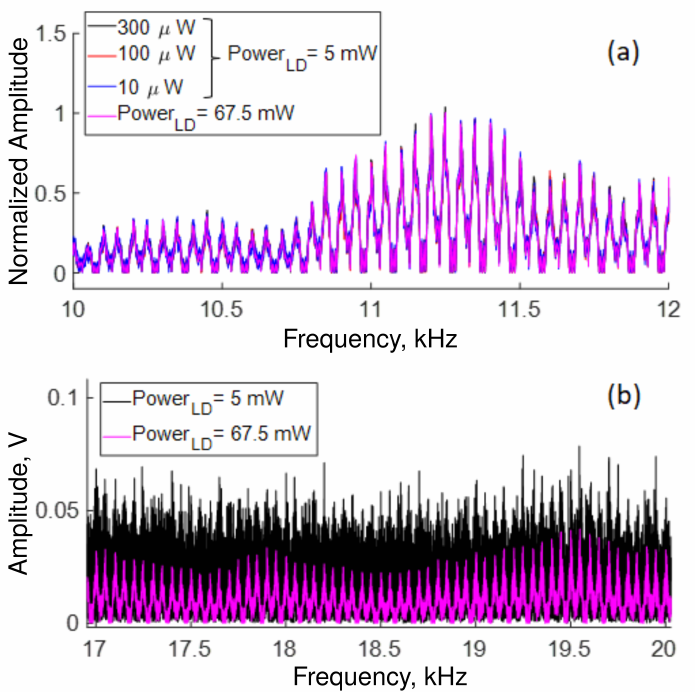
Figure 11. Influence on transmission response of ( a ) polarizer transmission and LD output power in the 12 kHz region, and of ( b ) LD output power at high frequencies